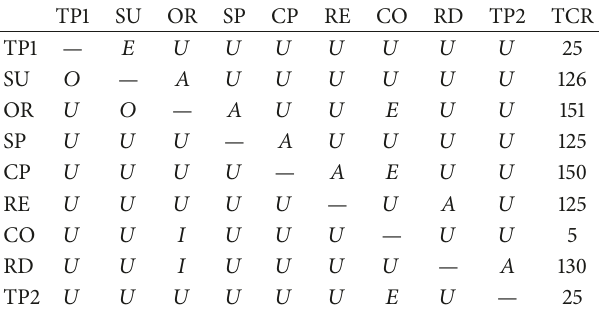
Table 5: Activity relationship